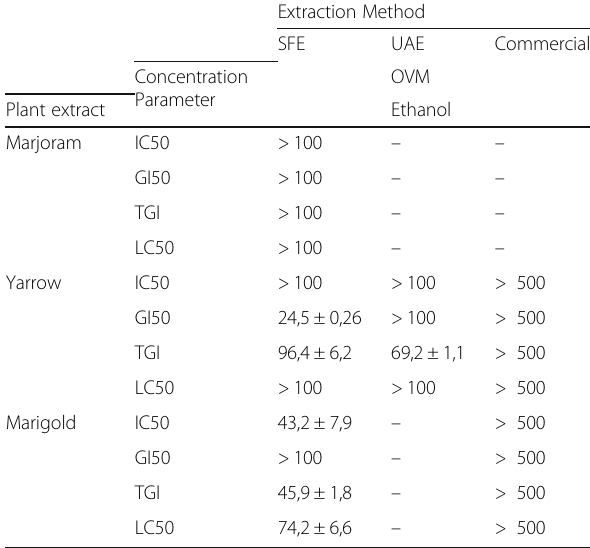
Table 2 Concentration parameters of the selected plant extracts on PANC-1 cell line sensitivity depending on the extraction